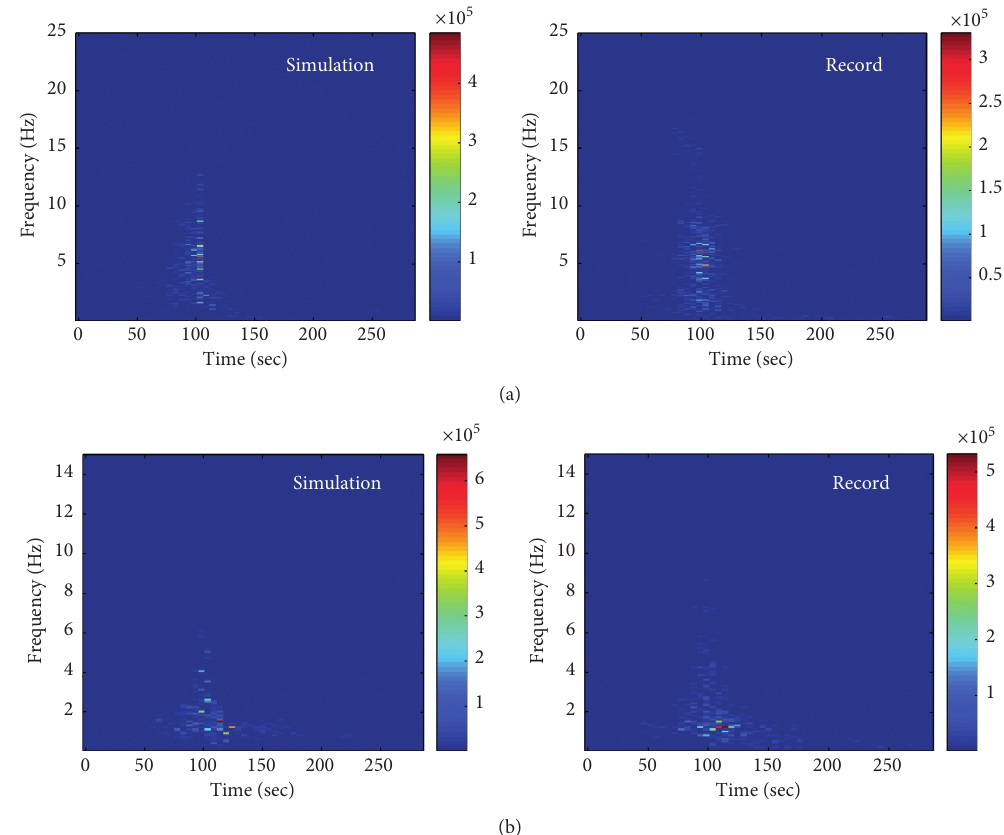
Figure 15: Comparison of the simulations with the records with respect to wavelet coefficients. (a) CHB002EW and (b)